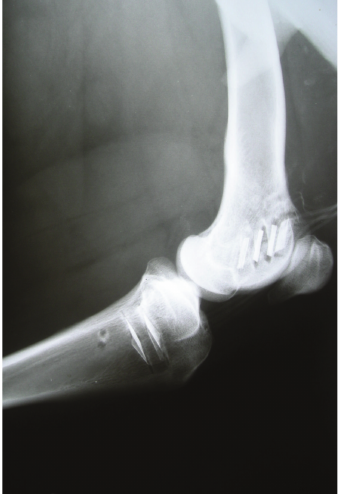
Figure 2: Postoperative radiograph thirty days after implantation showing the six actuators in place (four in the femur, two in the tibia). There are neither signs of periostal or peri-implantar reaction nor signs of infection in neighboring soft